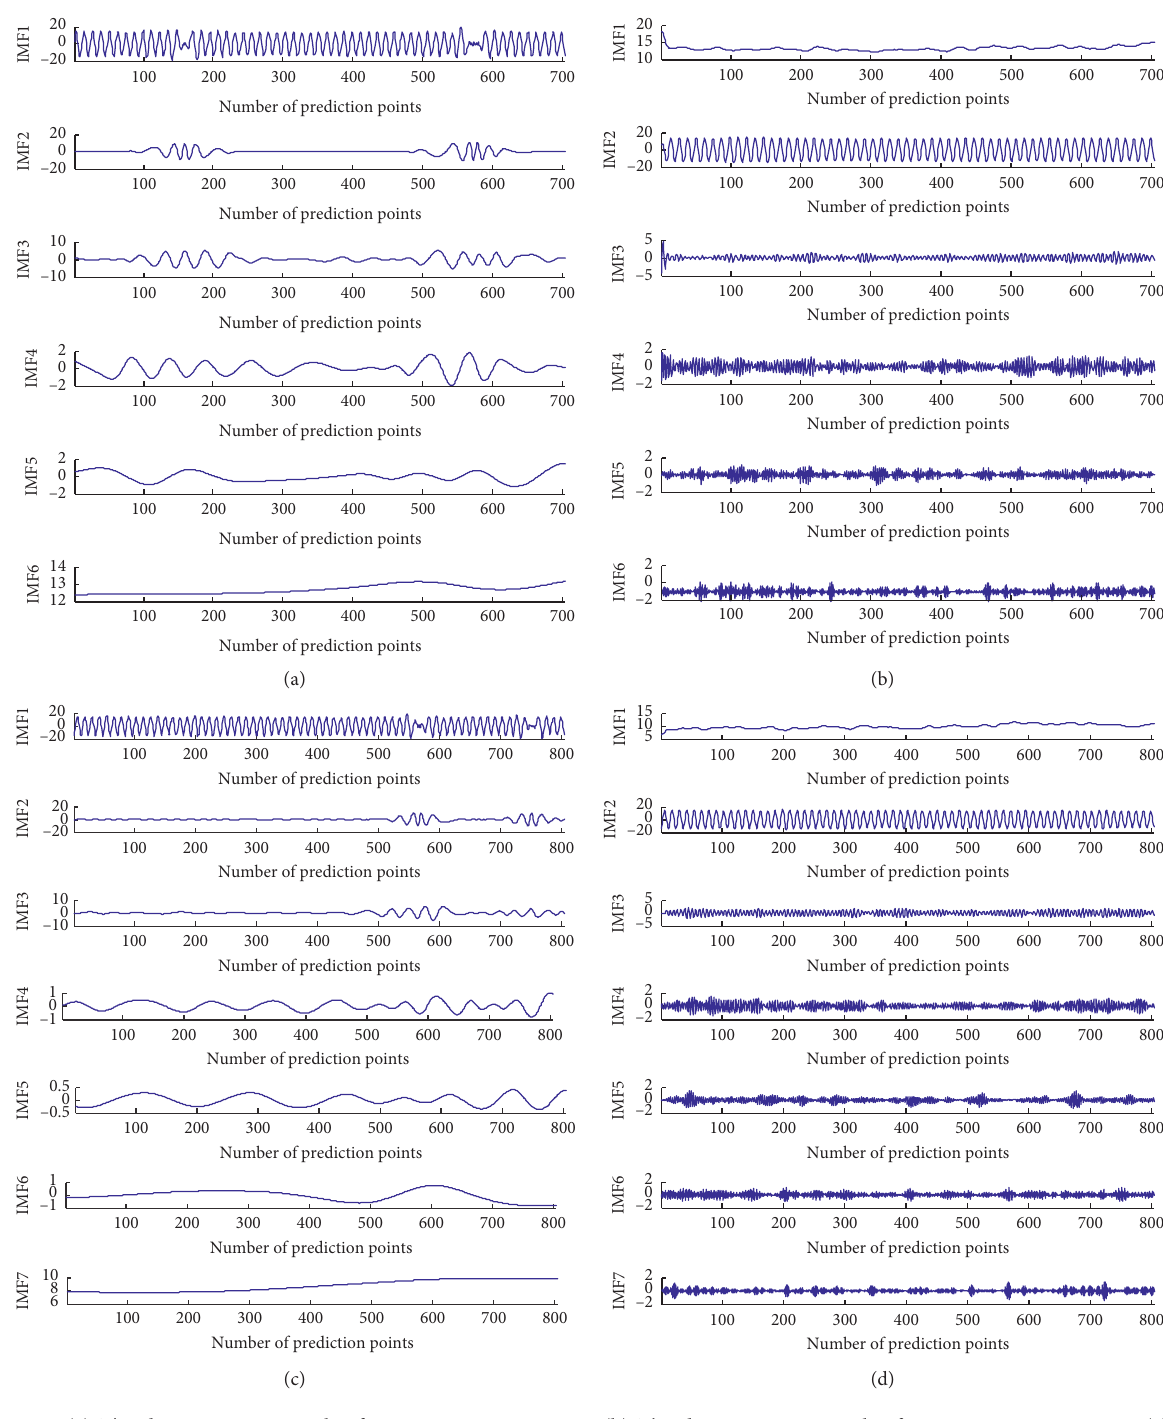
Figure 6: (a) The decomposition result of EMD in Xianyang area. (b) The decomposition result of VMD in Xianyang area. (c) The decomposition result of EMD in Yan’an area. (d) The decomposition result of VMD in Yan’an area. Table 1: Recombined by the DSE value of VMD subsequence in Xianyang